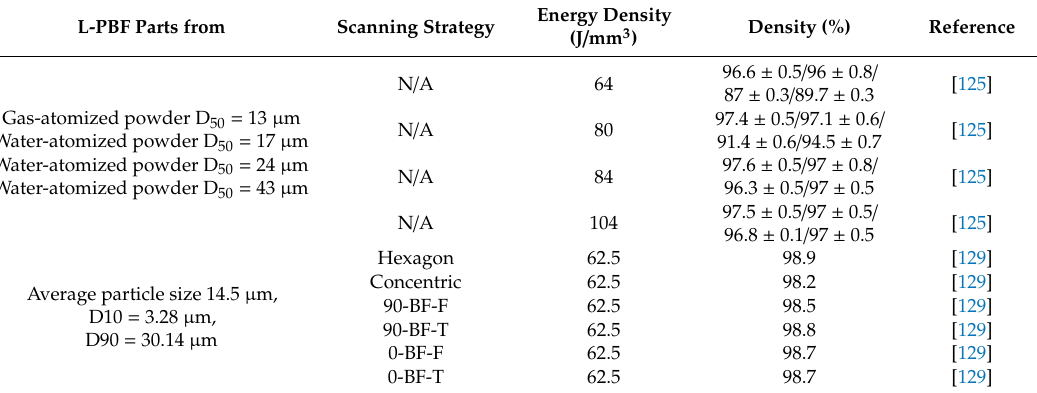
Table 5. The e ff ect of energy density and scanning strategy on the density of L-PBF parts (material: 17–4 steel). L-PBF Parts from Scanning Strategy